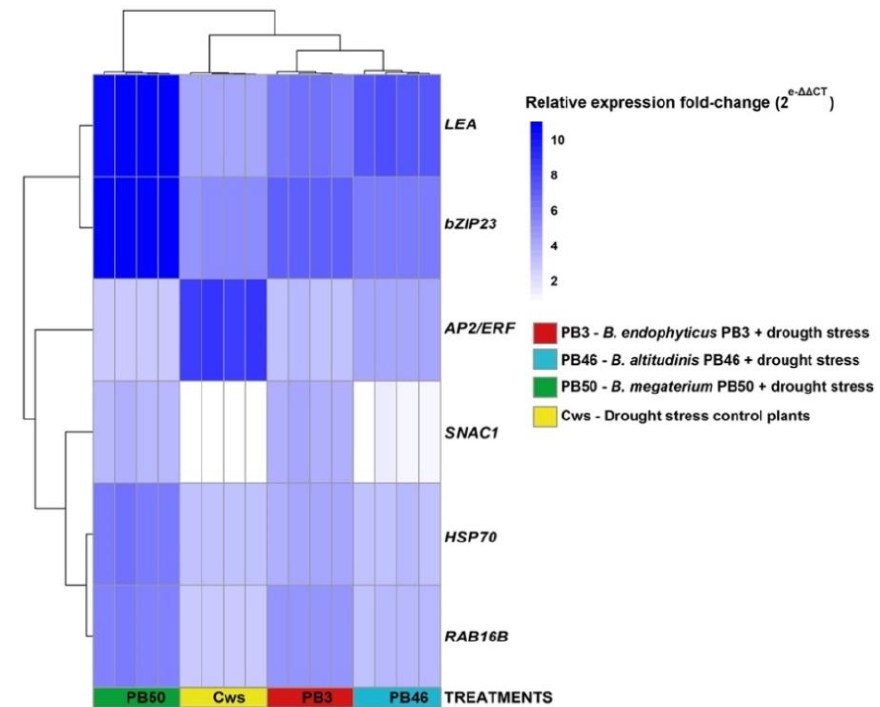
Figure 3. Heatmap showing the fold-change expression of genes in different treatments and clustering of samples according to the relative expression of the set of analyzed